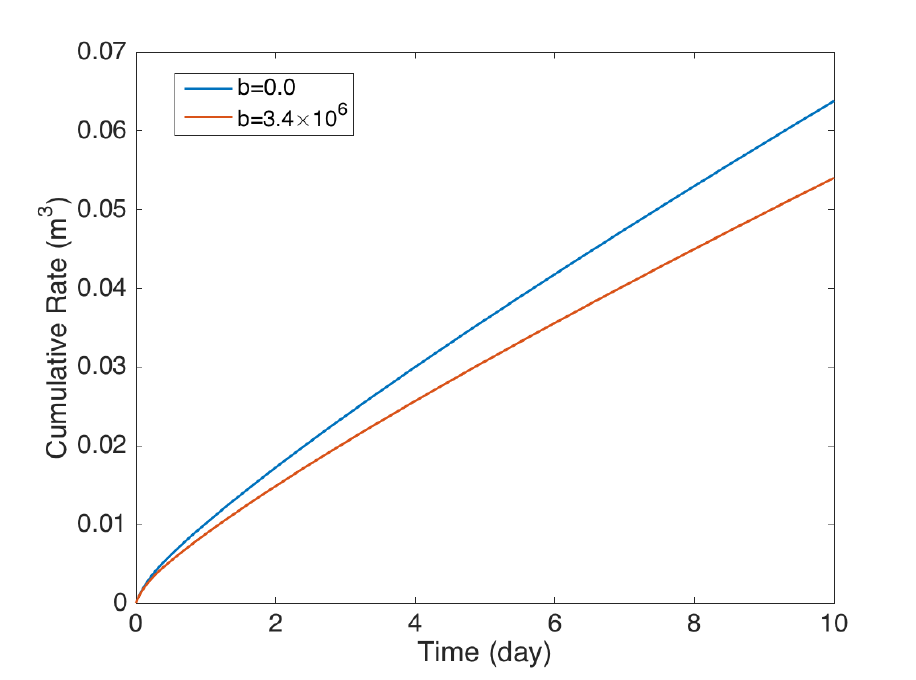
Figure 4. The cumulative production for various values of the coefficient b.